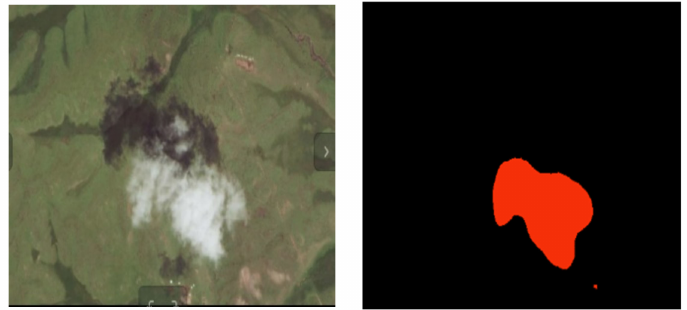
Figure 11. Testing results of the proposed method on a Google Earth